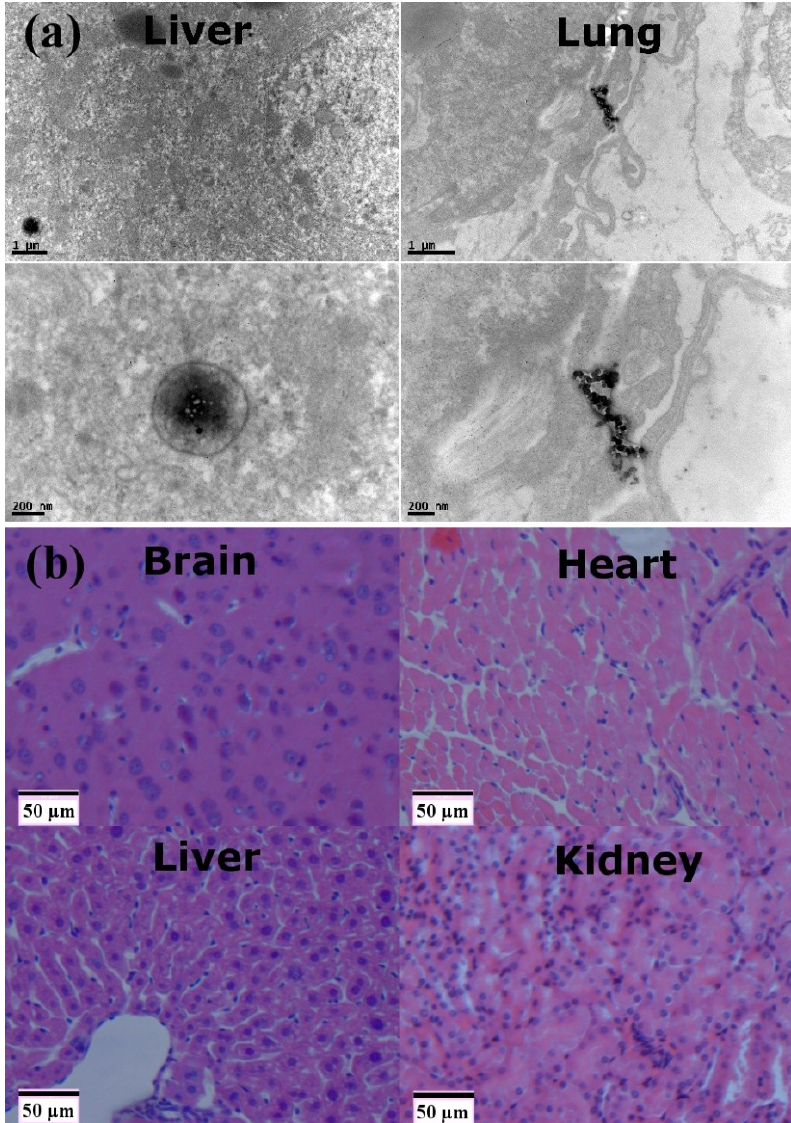
Figure 5. ( a ) The biodistribution of the dual-modality nanoprobes at the subcellular level. transmission electron microscopy (TEM) images from the liver and lung in mice 24 h after intravenous administration; and ( b ) Pathological biopsy assay on brain, heart, liver and kidney on the dual-modality nanoprobes stained with hematoxylin and eosin (H&E) and prussian